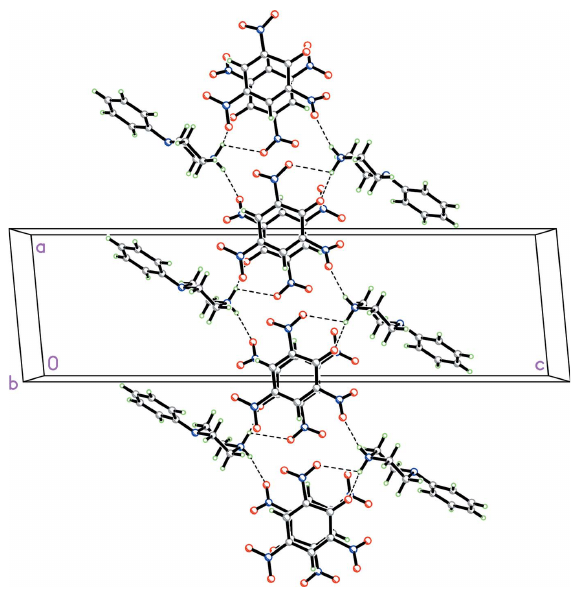
Figure 21 Packing diagram for 8 viewed along the b axis showing how the picrate anions form (cid:2) – (cid:2) interactions in the a -axis direction.